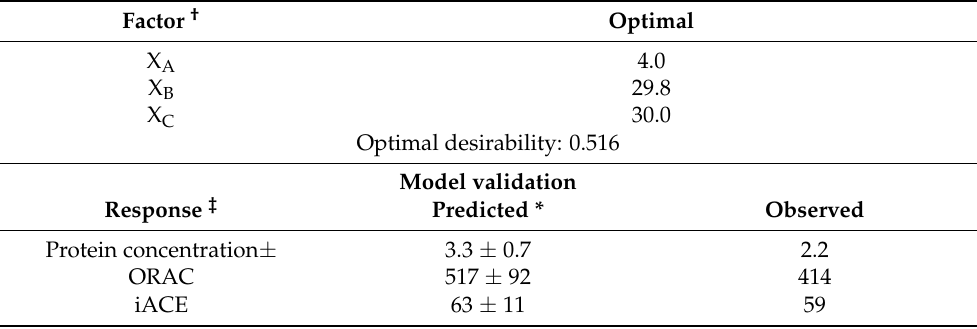
Table 3. Derringer optimisation and model validation.